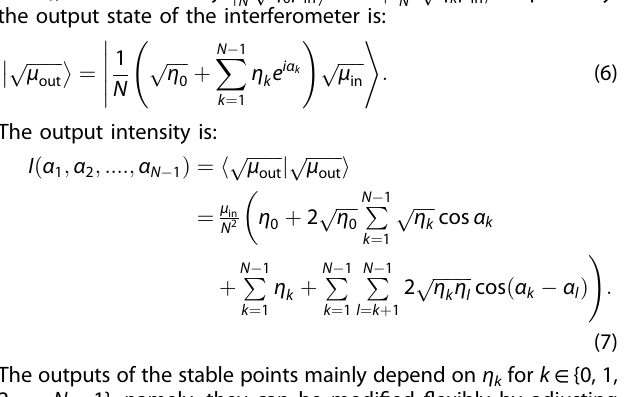
ffiffiffiffiffiffiffiffiffiffi p μ η i respectively. k in